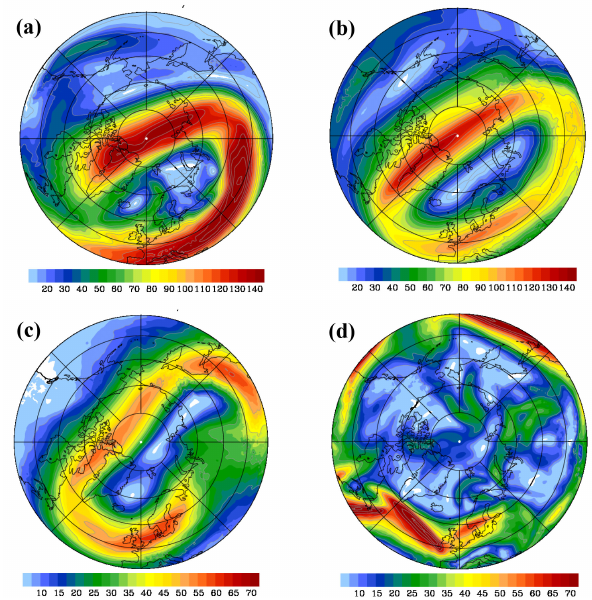
Figure 1. Magnitude of the balanced wind V BAL shaded) from the normal-mode analysis at pressure surfaces of 1hPa (a) , 5hPa (b) , 50hPa (c) , and 250hPa (d) valid on 30 Jan- uary 2016